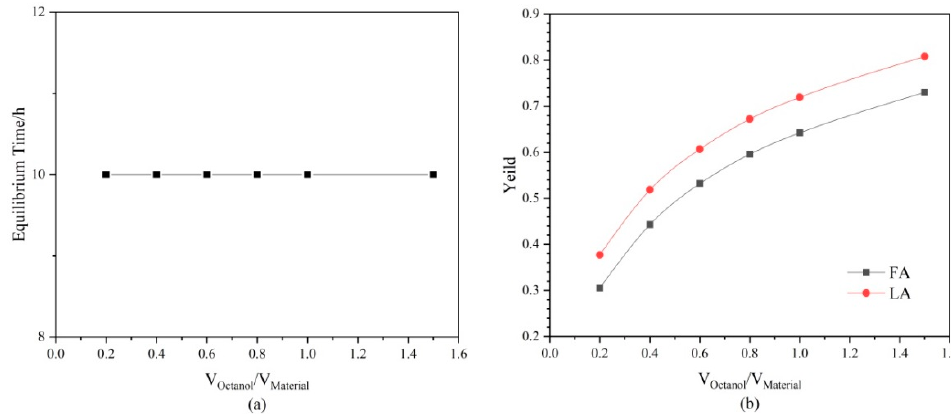
Figure 9. Effect of initial reactant ratio on the yields of ( a ) LA and ( b ) FA. Above all, with 20% H-ZSM-5 dosage, 600 rpm, 363.15 K and initial n-octanol/aqueous phase volume ratio 1.5:1, the yield of FA was 73%, the yield of LA was 80.8%.